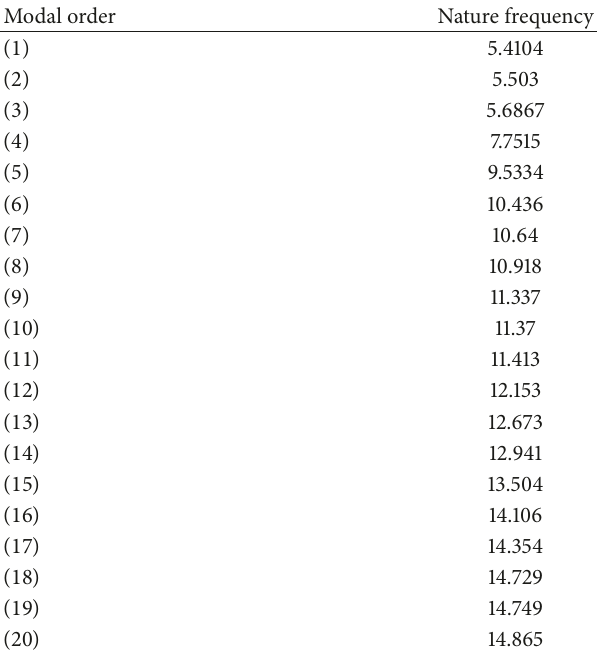
Table 2: Natural frequencies of existing